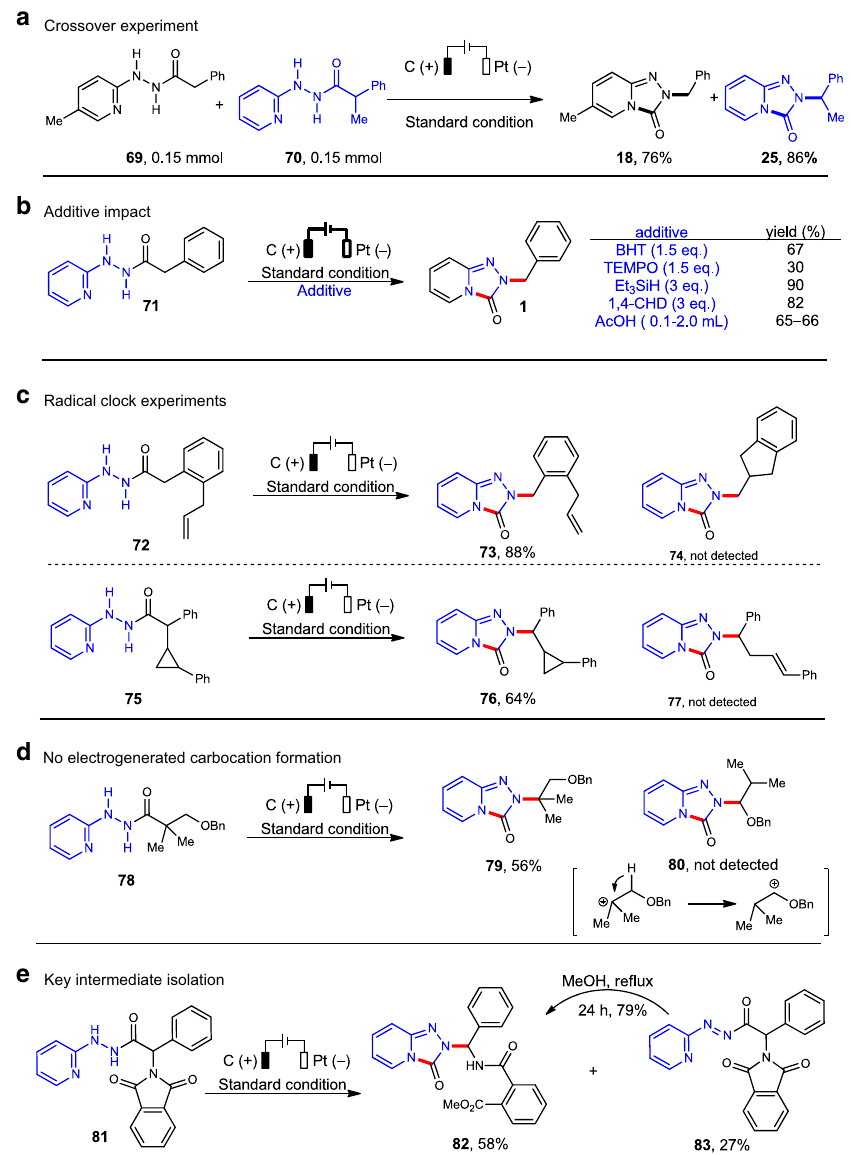
Fig. 4 Control experiments and mechanistic probes. a Crossover experiments. b Impact of additives. c Radical-clock experiments. d Control experiment to demonstrate no electrogenerated carbocation formation. e Key intermediate